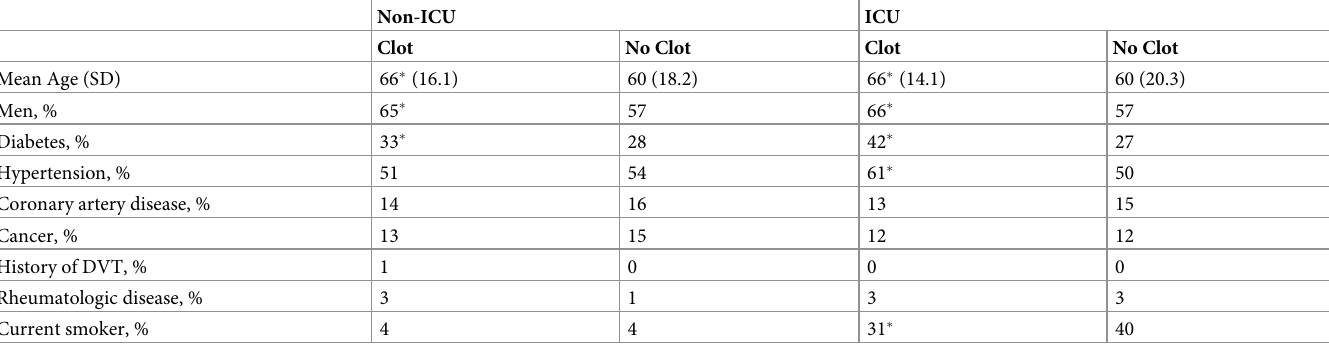
Table 1. Baseline characteristics of COVID-19 patients with and without clotting events (venous or arterial) in the non-ICU and ICU